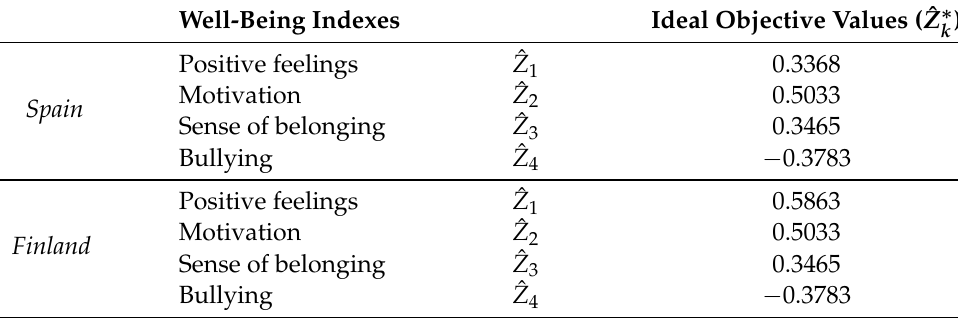
Table 12. Ideal objective values of the deterministic problems for Spain and Finland.